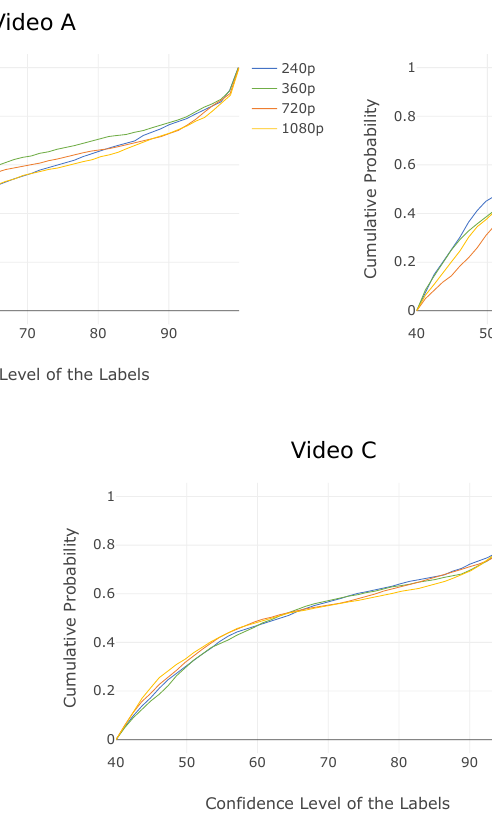
Figure 9. Empirical cumulative distribution function of the confidence level associated with the labels at different video resolutions for AR in three different videos: A, B and